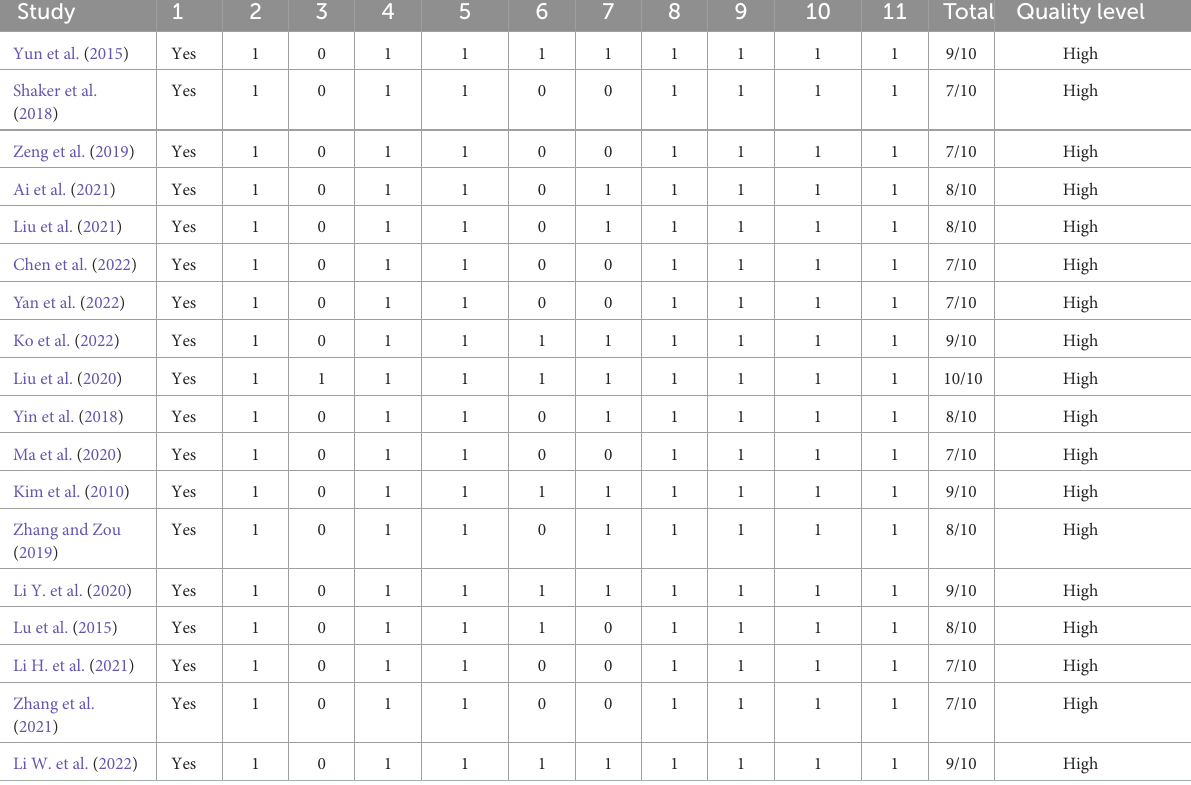
TABLE 2 Physiotherapy evidence database scores of the included